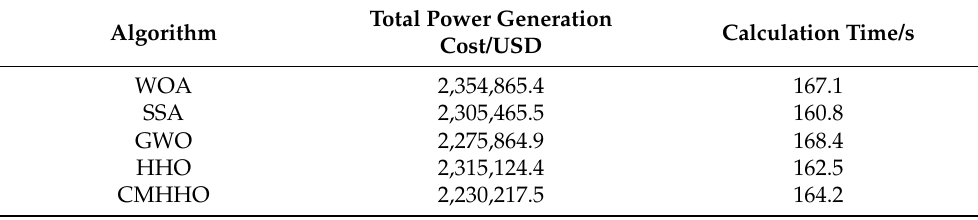
Table 7. Comparison of test results of different algorithms (two-region 78-node interconnected